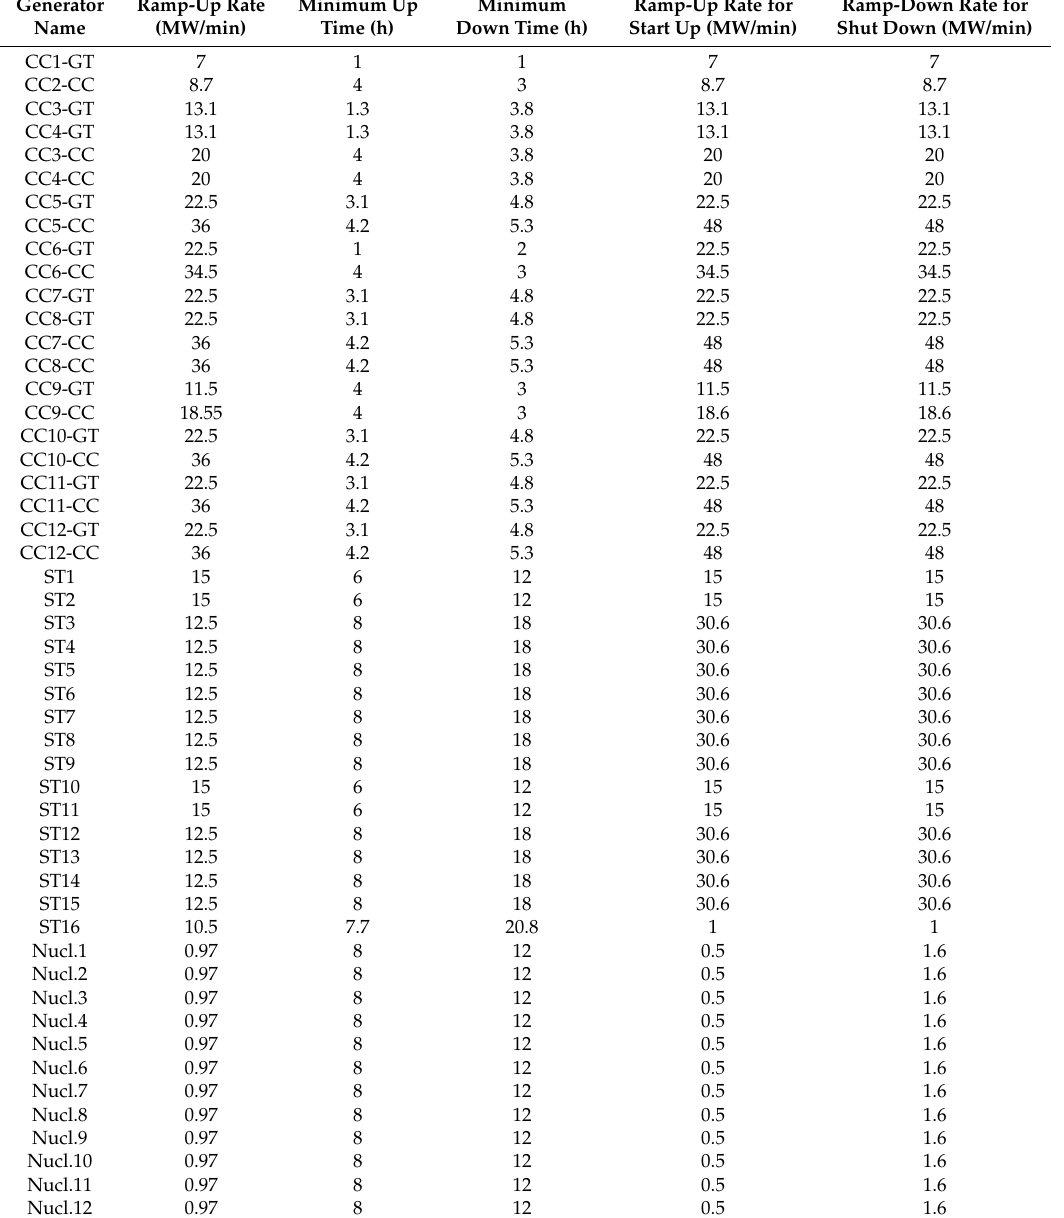
Table A2. Ramp and on/off